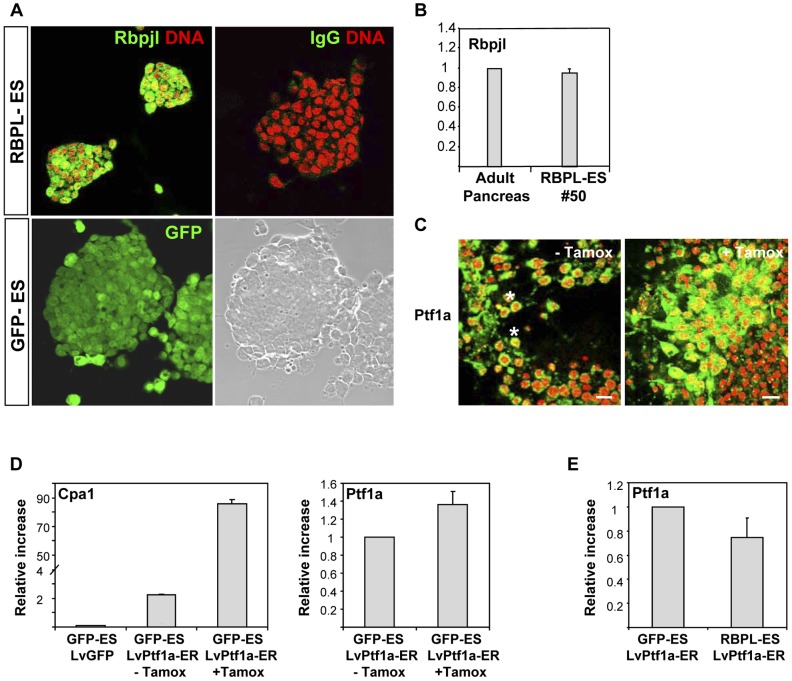
Characterization of transgene expression in undifferentiated and differentiated ESC lines.A) Analysis of transgene expression in RBPL-ES. Undifferentiated RBPL-ES were stained by immunofluorescence with an anti-Rbpjl antibody or an irrelevant one (green) and with Tropo3 (red) to label nuclei. GFP expression in GFP-ES cells was analyzed by confocal microscopy. The engineered ESC lines displayed a normal karyotype and retained their self-renewal capacity (not shown). Scale bars, 50 µm. B) Rbpjl mRNA levels of clone # 50 were comparable to those of mouse adult pancreas by qRT-PCR. C) Immunofluorescence analysis of Ptf1a expression and relocalization in differentiating ESC infected with Lv-Ptf1a-ER and treated with DMSO (−) or with Tamox (+), two days after. Ptf1a expression is shown in green while the nuclei are stained in red. Asterisks (*) show nuclear Ptf1a staining in cells non-exposed to Tamox. Scale bars, 10 µm. D) qRT-PCR analysis of Cpa1 expression in GFP-ES cells differentiated through the protocol until the end of stage 3. Cells were infected with a control LvGFP or the Lv-Ptf1a-ER and incubated with or without Tamox. Ptf1a mRNA expression is also shown as an indicator of LvPtf1a-ER gene transduction. E) qRT-PCR analysis of ectopic Ptf1a mRNA expression at the end of the protocol in GFP-ES and RBPL-ES cultures infected with LvPtf1a-ER.